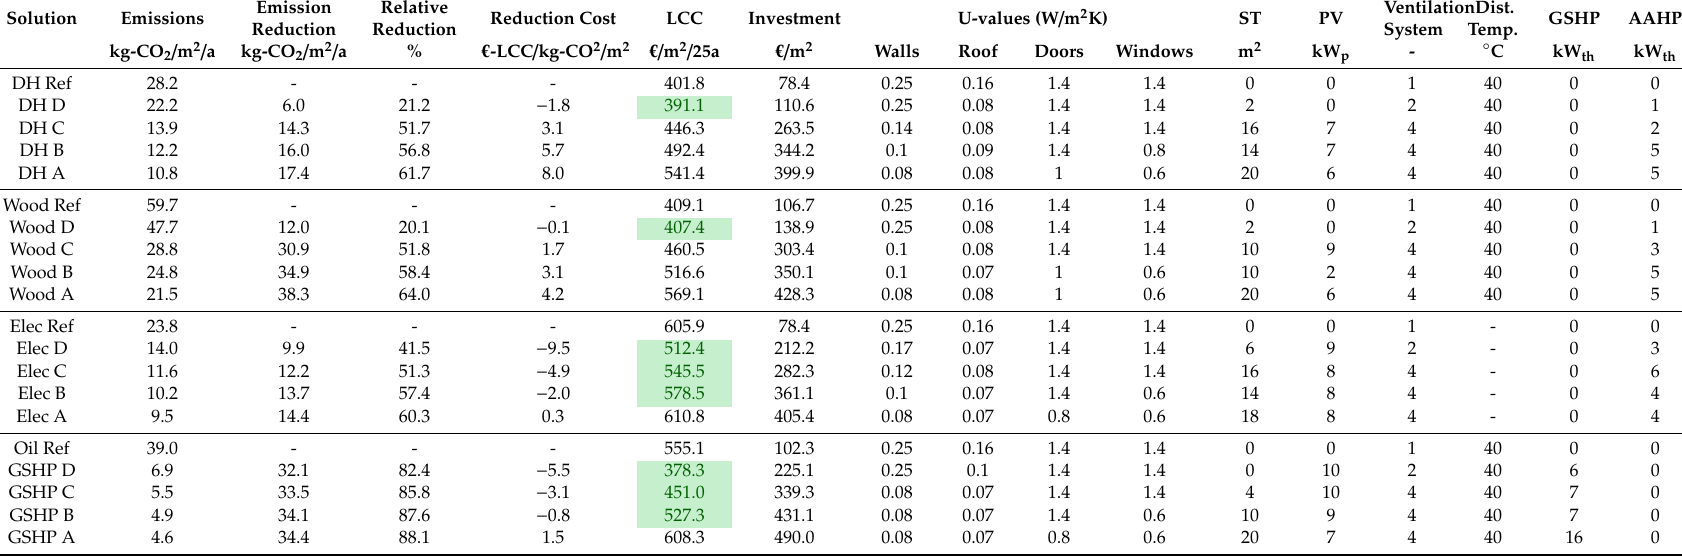
Table 13. Selected optimal cases for SH3 with all heating systems. Cost-e ff ective solutions are marked in green. Cases D to A are optimized solutions from the lowest to the highest LCC. For the ventilation system: 1 is mechanical supply and exhaust ventilation with 60% HR e ffi ciency, 2 is mech. S & E ventilation with 60% HR and VAV, 3 is mech. S & E ventilation with 75% HR, and 4 is mech. S & E ventilation with 75% HR and VAV.